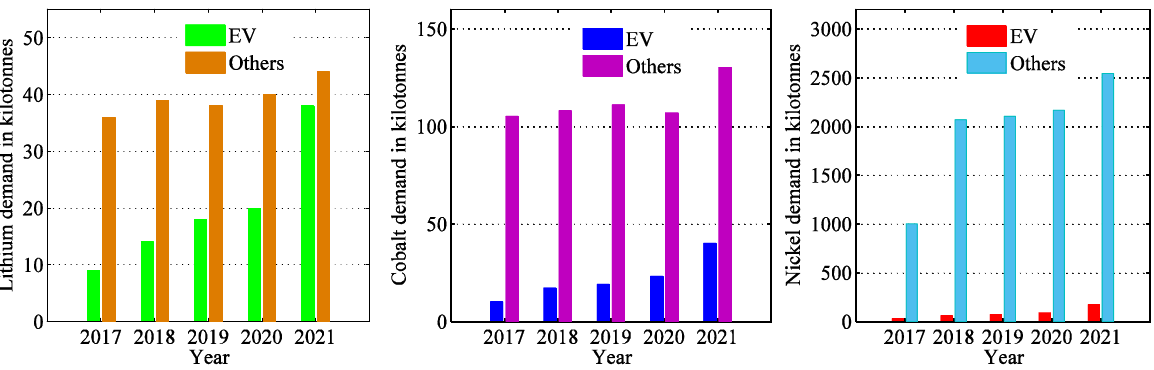
Figure 5. Lithium, cobalt, and nickel demands in EVs and other applications from 2017 to 2021.